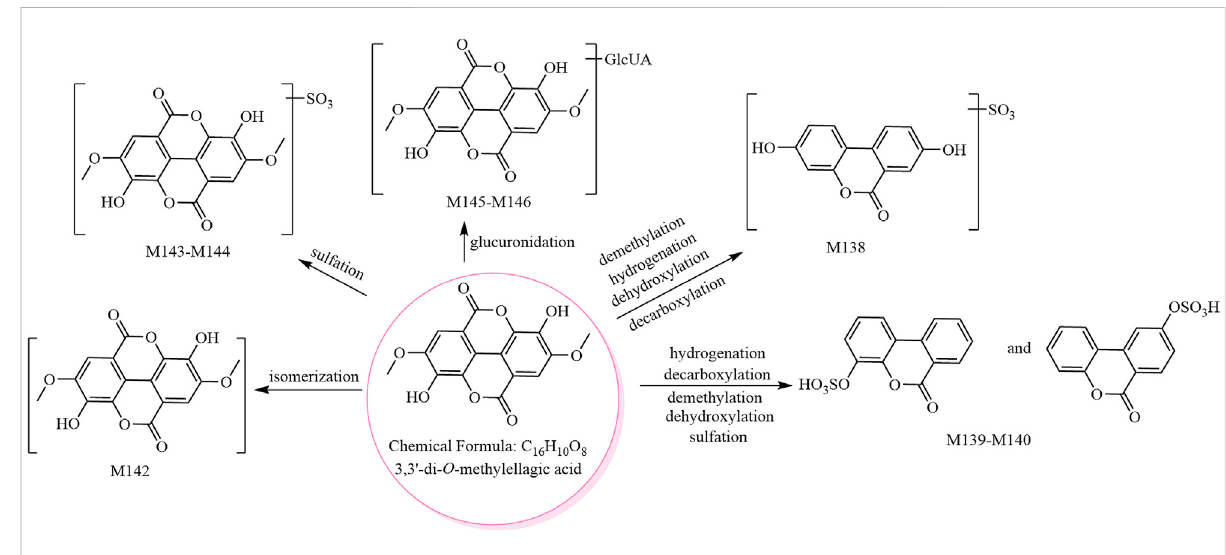
FIGURE 3 The eight metabolites (all new) and proposed metabolic pathways of 3,3 ′ -di -O- methylellagic acid in